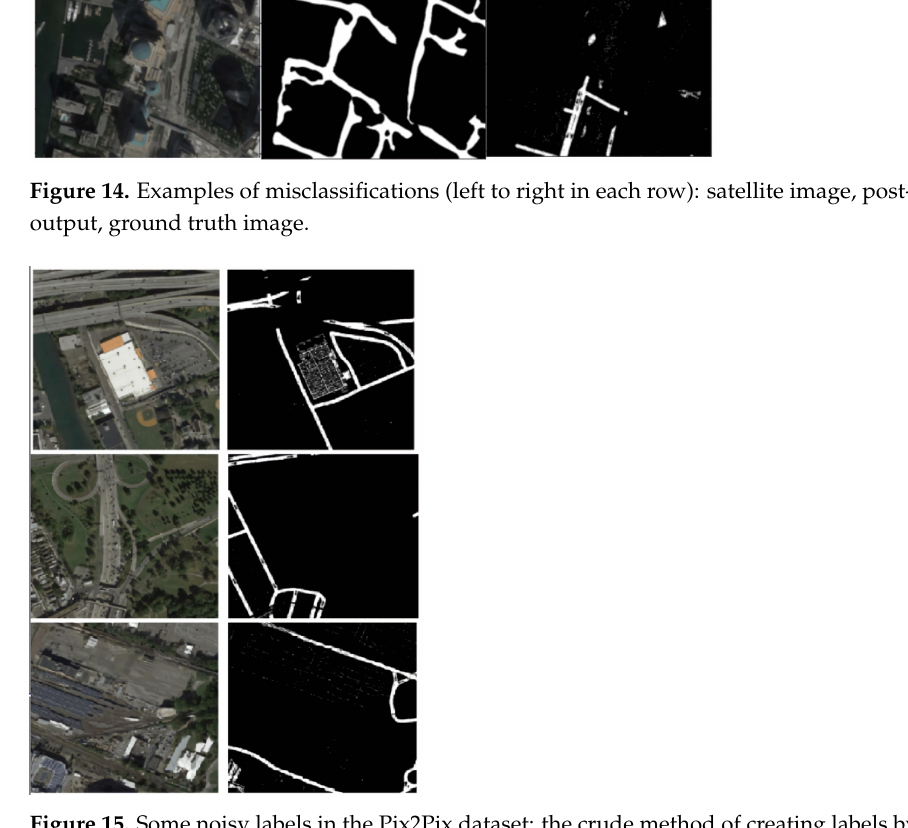
Figure 15. Some noisy labels in the Pix2Pix dataset: the crude method of creating labels by applying thresholds on the black and white image introduced errors into the dataset, thereby limiting the performance of